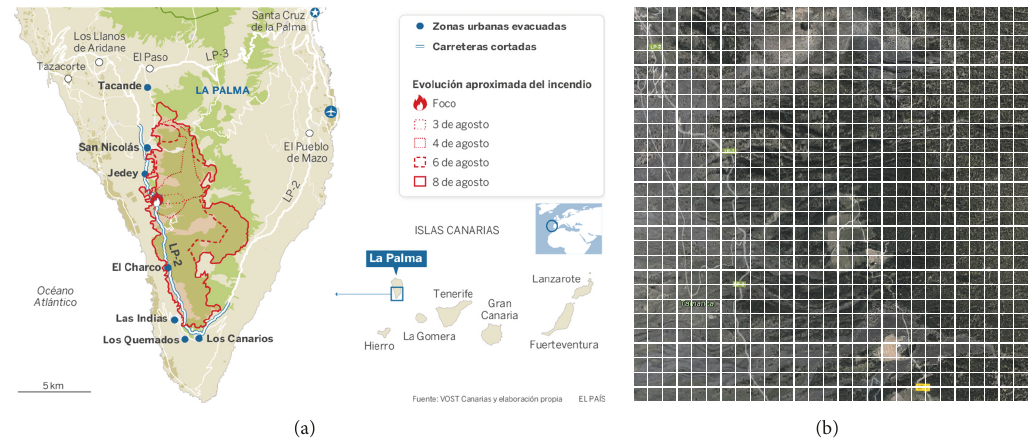
Figure 1: La Palma fire map (a) and gridding searching area